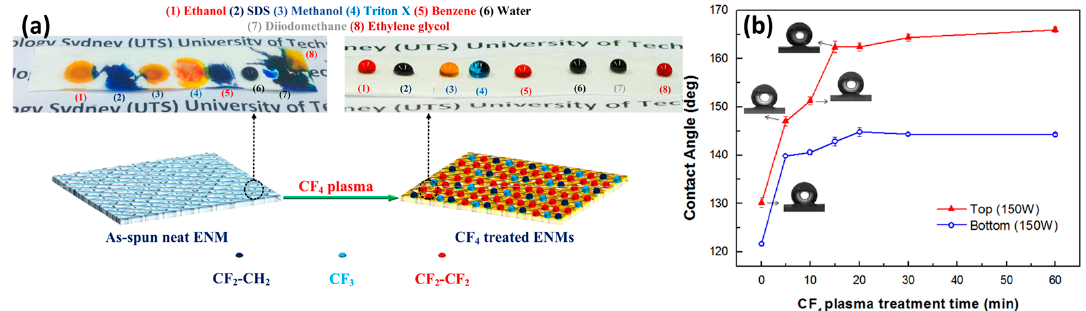
Figure 11. ( a ) Schematic illustrations of the neat and CF 4 plasma-modified electrospun nanofiber membranes. Reprinted from [66]. Copyright (2017) with permission from Elsevier. ( b ) Water contact angles of top/bottom PVDF membrane surface as a function of CF 4 plasma treatment time. Reprinted from [64]. Copyright (2014) with permission from Elsevier.